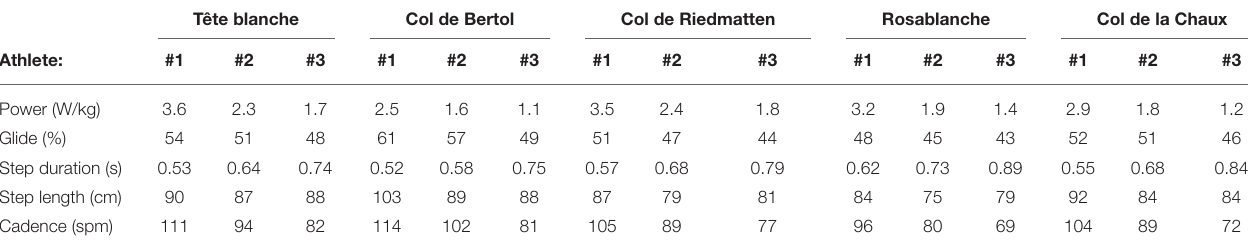
TABLE 4 | Spatiotemporal parameters for athlete #1 and amateur athletes #2 and #3 in the five uphill parts of the race. Tête blanche Col de Bertol Col de Riedmatten Rosablanche Col de la Chaux